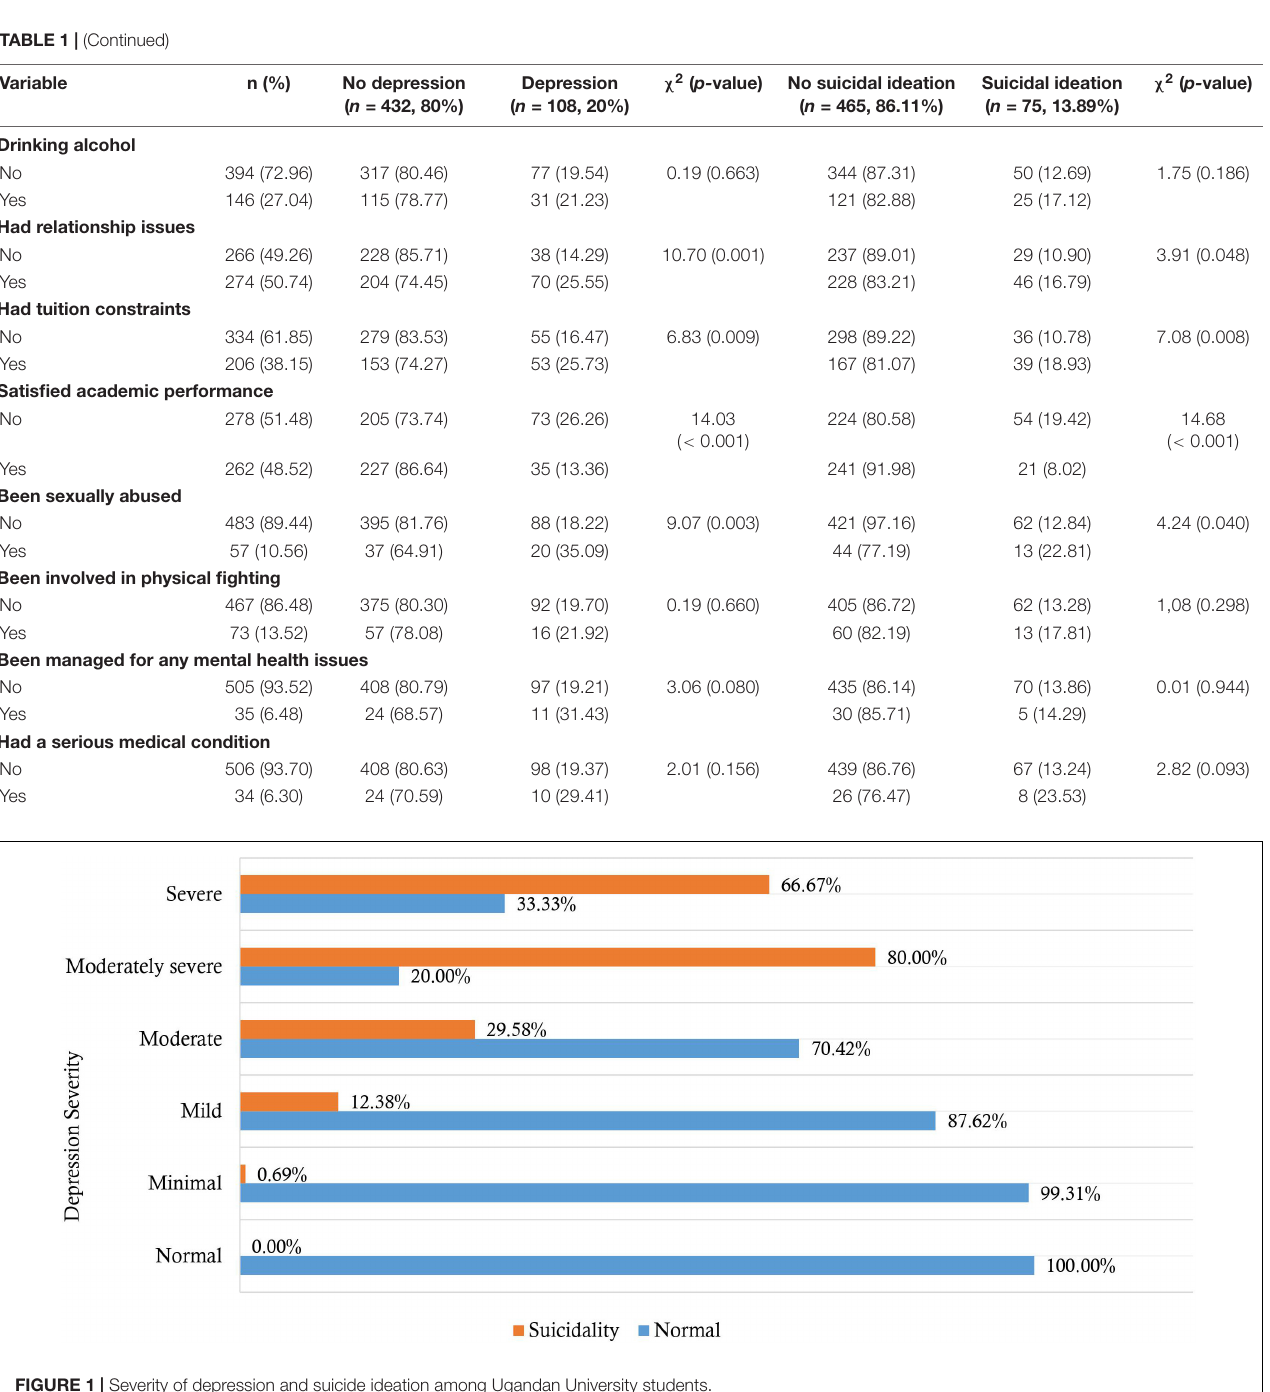
collinearity, and they all had VIFs below 3, with a mean VIF of 1.11. Consequently, they were included in the final model using the backward stepwise selection method. The model had a sensitivity of 4.00%, specificity of 100%, a positive predictive value of 100%, a negative predictive value of 86.59%, and correctly classified 86.67% of depression. The goodness-of-fit p- value was 0.934 for the included six variables ( Table 2